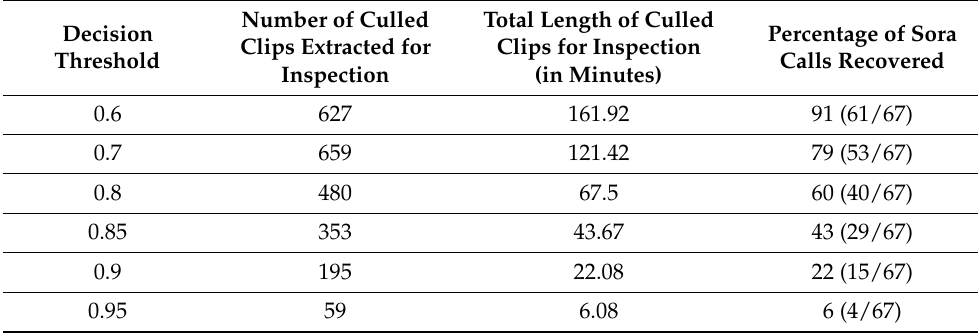
Table 5. Number of culled clips (of variable length), total length of clips, and percentage of Sora vocalizations recovered by culled clips on the extended validation dataset.